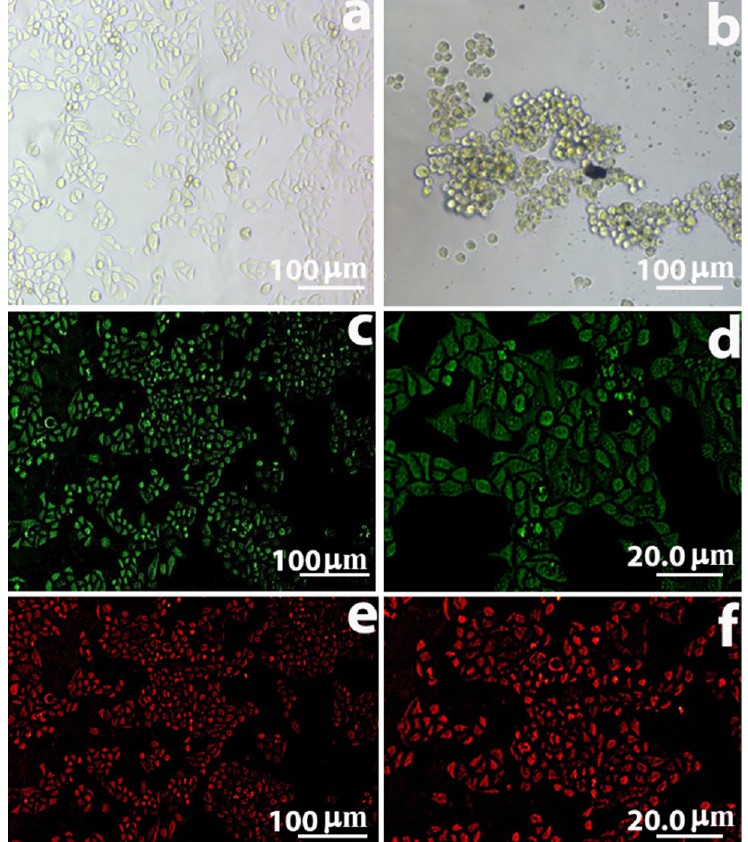
Figure 7. Binding assays–attachment of conjugate MNP-MTX-FR Ab to HeLa cells. Figure ( a ) Control. ( b ) Binding of conjugate MNP-MTX-FR Ab to HeLa cells. ( c , d ) Attachment of the FR antibody to HeLa cell’s folate receptor. ( e , f ) Attachment of MTX antibody to drug MTX. 3.9. Receptor Binding Assay of Nanomedicine with Tumor Tissue (Immunohistochemistry)